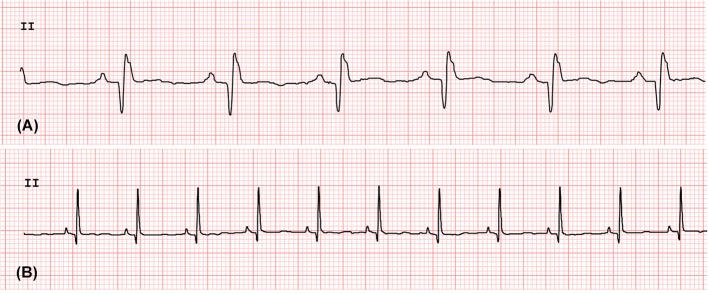
The standard 6-lead ECG waves obtained from the rhesus macaques with LVH (A) and without LVH (B). The lead II strips were obtained at the paper speed of 50 mm/s and vertical ECG calibration of 20 mm/mV.